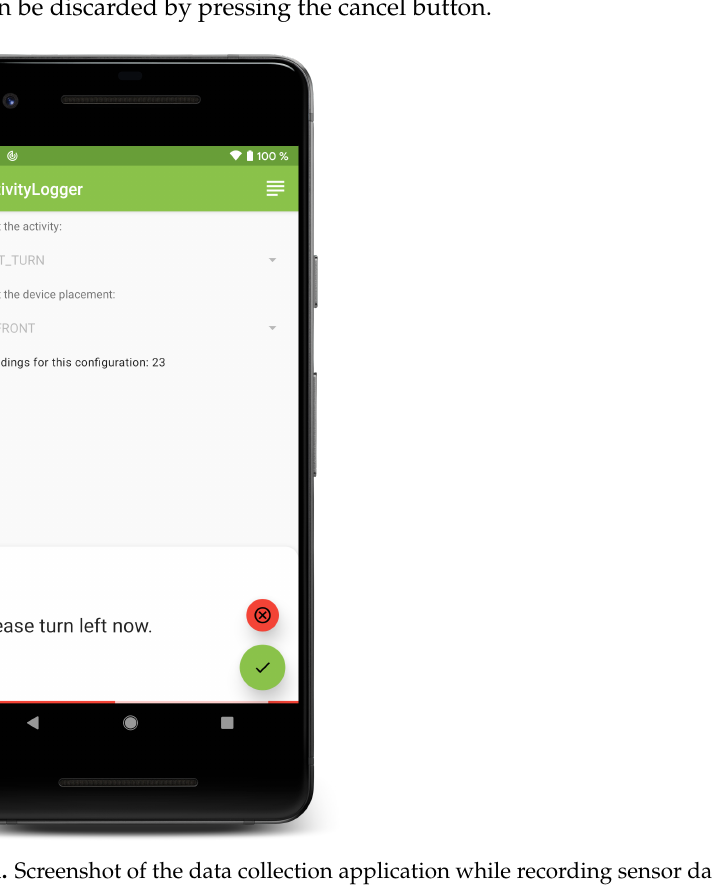
Figure 1. Screenshot of the data collection application while recording sensor